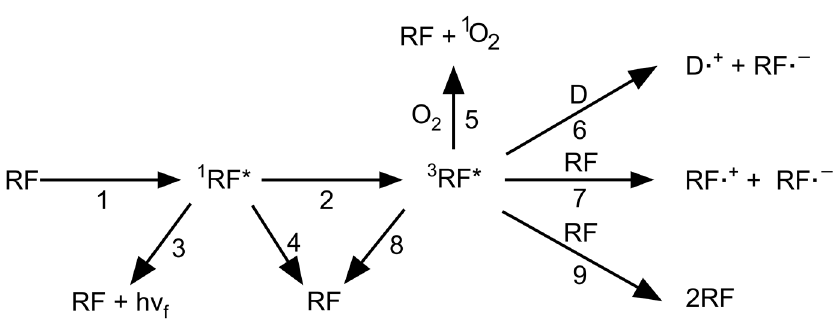
Figure 2. Schematic of the mechanistic pathways for the formation of intermediates by RF. Adapted with permission from [39].